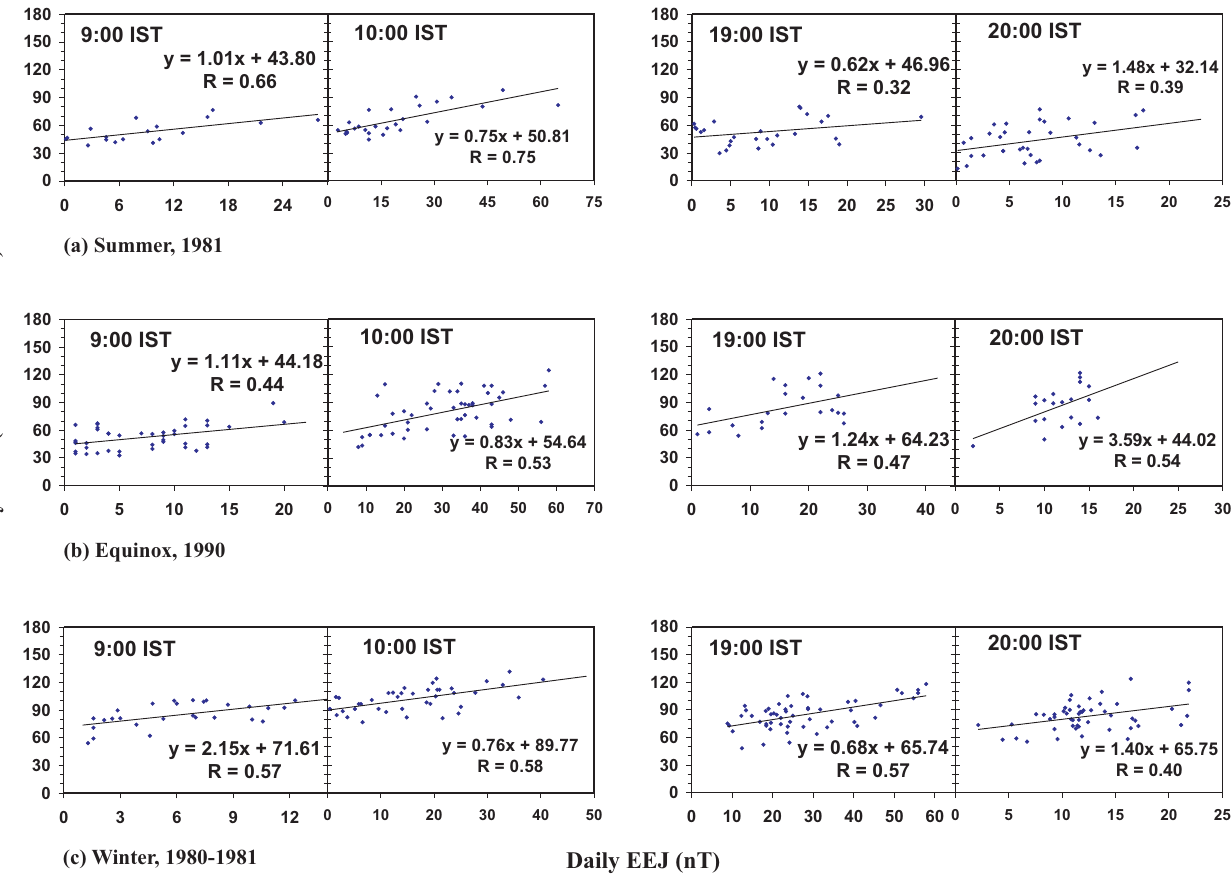
Fig. 1. Daily values of TEC at the specified time ( t h) vs. EEJ strength (nT) at time ( t − 2h) for (a) summer solstitial months (May, June, July), (b) equinoctial months (August, September, October) and (c) winter solstitial months (November, December, January) of the indicated years. A linear regression line with equation and correlation coefficient ( R ) is shown in each case. 1TEC unit=10 16 electrons/m 2 . Time is given in h IST